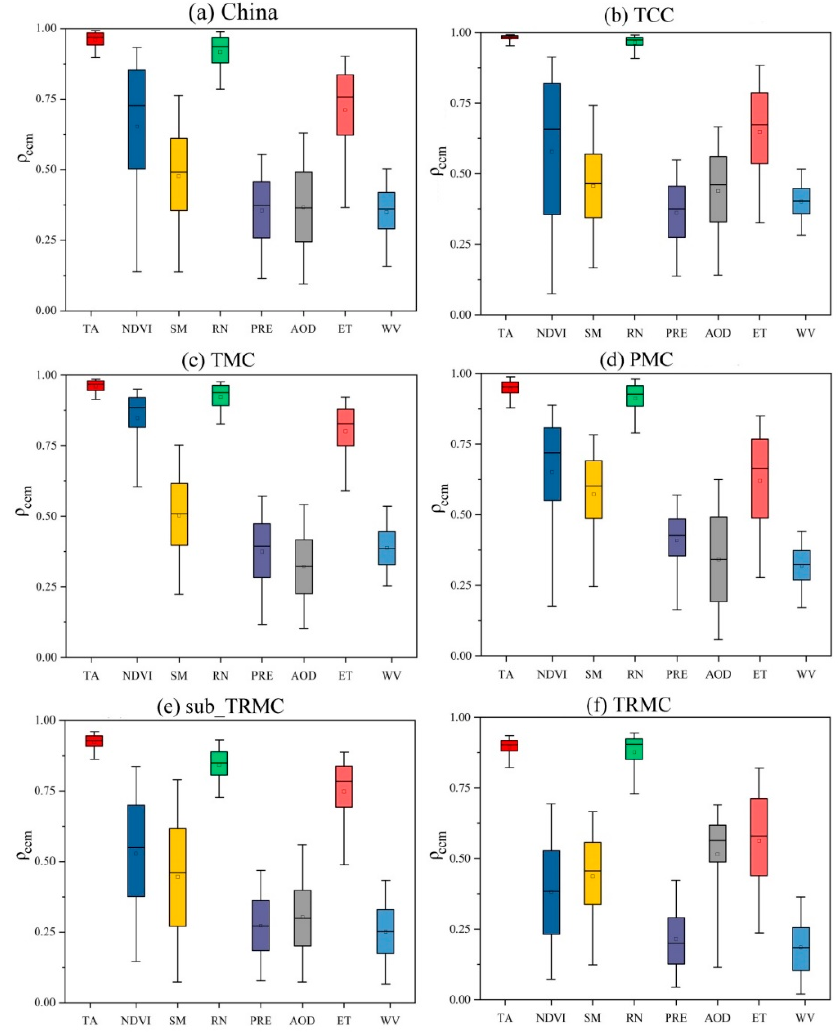
Figure 9. Boxplots of ρ ccm between LST and each environmental factor in China and each climate zone. ( a ) China ( b ) TCC region ( c ) TMC region ( d ) PMC region ( e ) sub_TRMC region ( f ) TRMC region. The upper and lower short lines represent 95% confidence intervals, the horizontal line is the median, and the square indicates the mean.